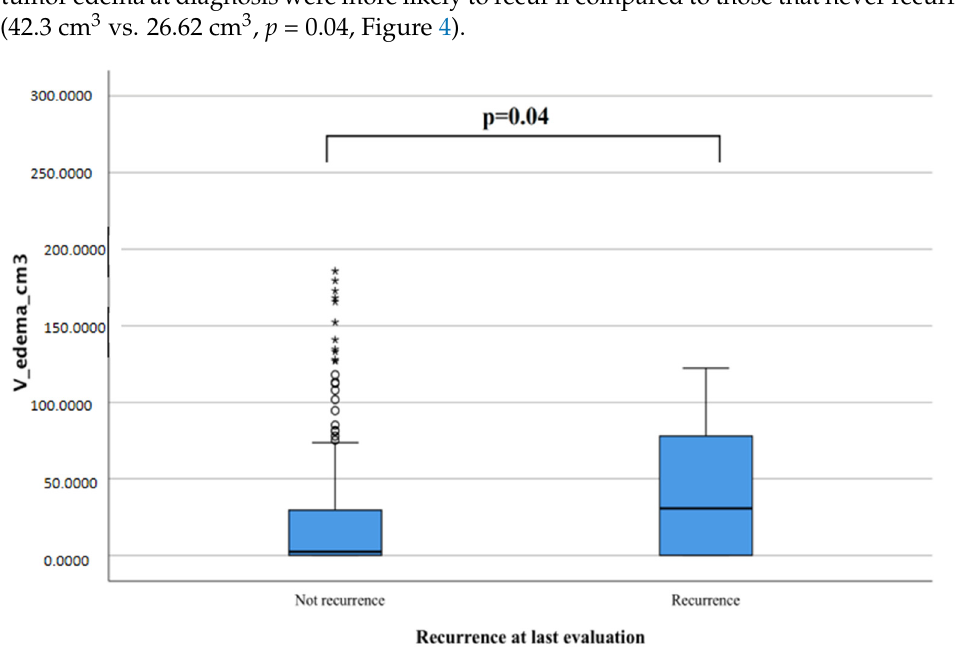
Figure 4. In the box letter graph, there is a significant difference between the group of patients developing recurrence with the total volume of edema ( p = 0.04). This difference appears to be independent of WHO grade.